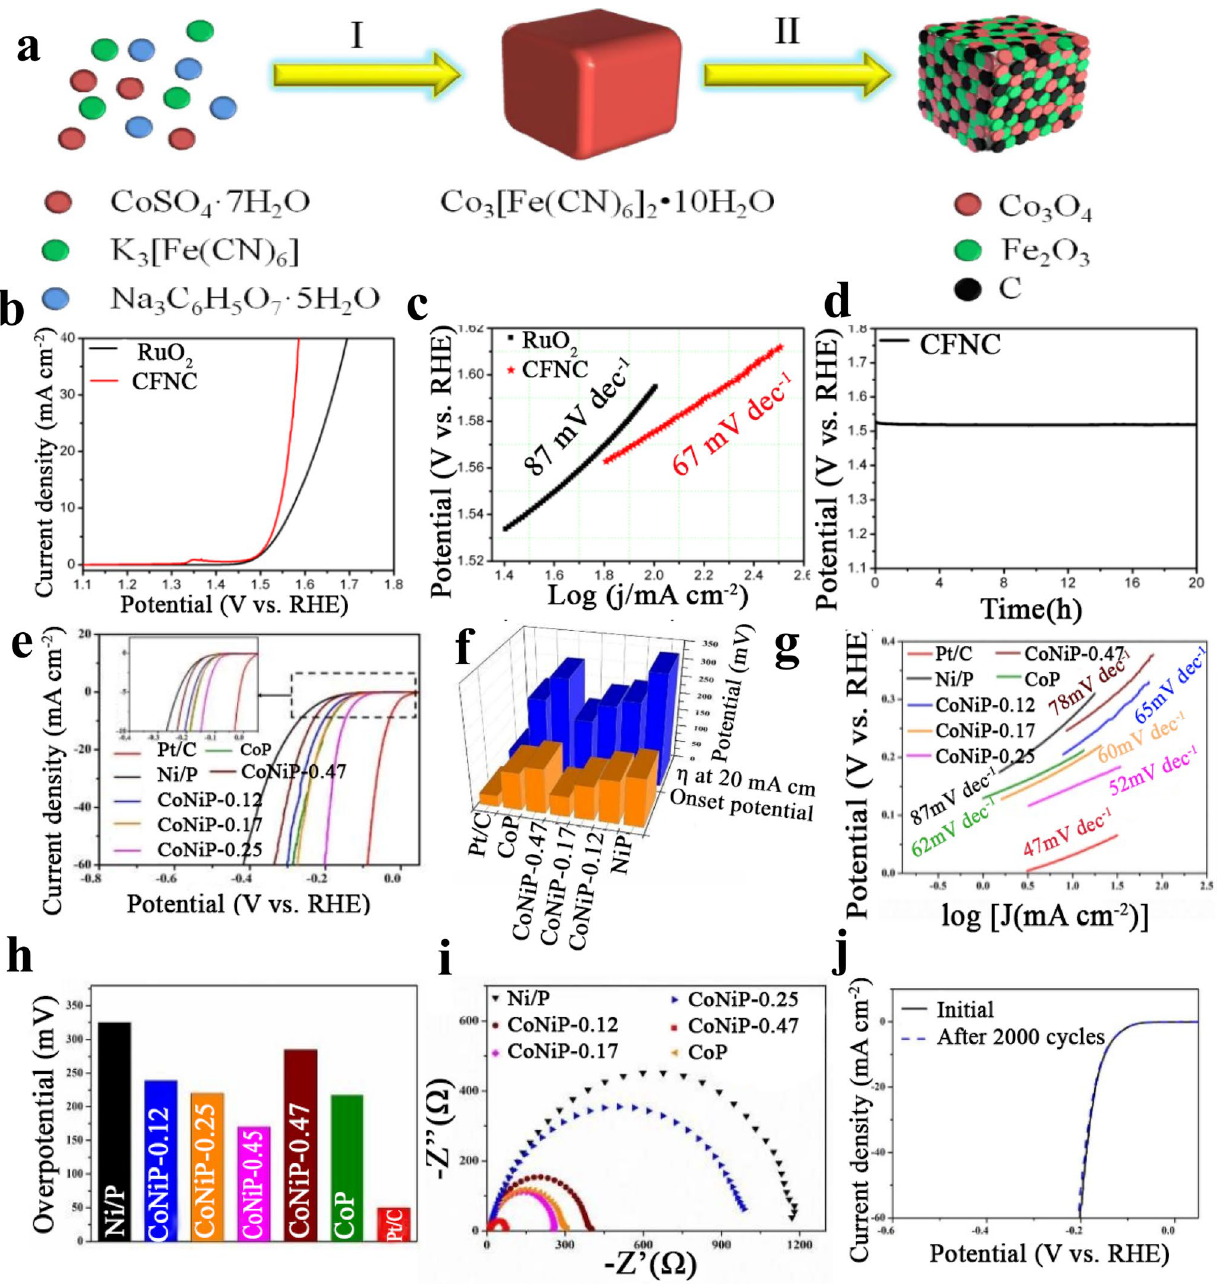
Fig. 9 a Schematic illustration of the fabrication processes of CFNC: (I) formation of Co 3 [Fe(CN) 6 ] 2 ·10H 2 O nanocubes; (II) calcinated in an air atmosphere to prepare CFNC; b polarization curves of CFNC and RuO 2 , respectively, c Tafel plots of CFNC and RuO 2 , respectively, and